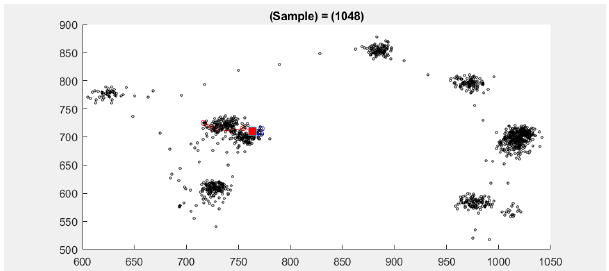
Figure 9 . Scatter plot for dataset 2.2 at sample 1048 (red square at sample 1048) shows two clusters very close to each other.